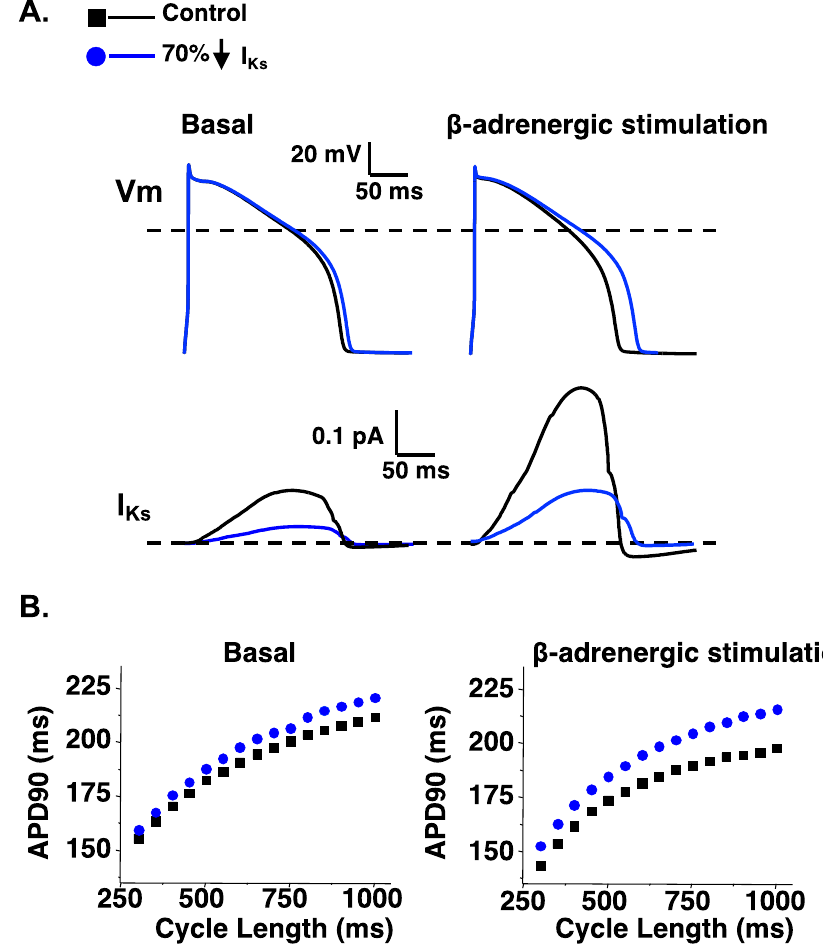
Figure 3. A reduction of I Ks predicts a larger prolongation in the APD90 following β -adrenergic stimulation. ( A ). Representative AP waveforms and the corresponding I Ks for control simulations